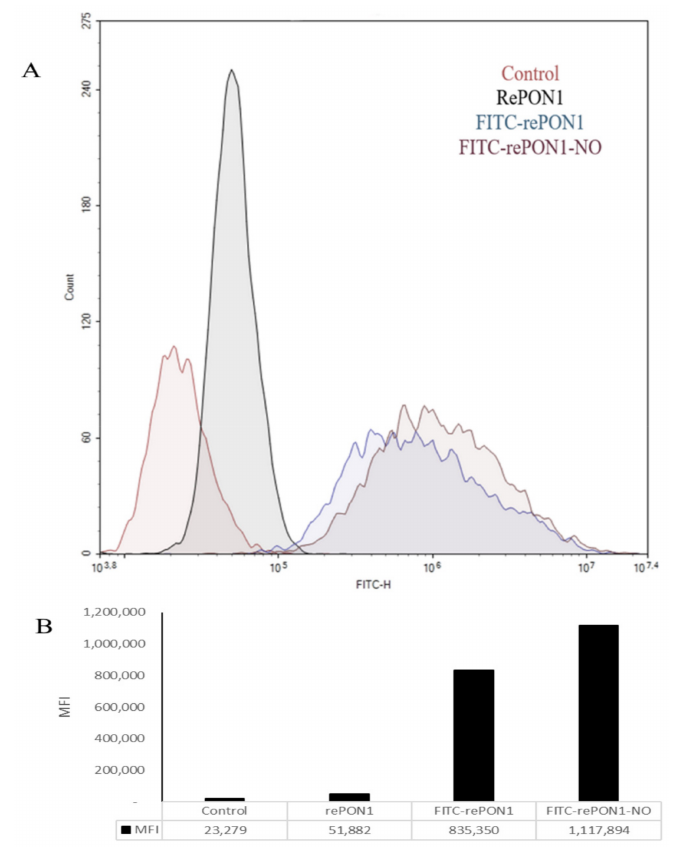
Figure 4. FITC-rePON1-NO influx into macrophage cells compared to FITC-rePON1. RePON1 was labeled with FITC and incubated with GSNO for 3 h to obtain 50% rePON1 S-nitrosylation. Then, rePON1-NO was added to J774A.1 macrophages, incubated at 37 ◦ C for 16 h and analyzed by FACS. ( A ) Histogram shows the shift in mean fluorescence intensity (MFI) in a representative experiment. Control (cells without treatment) in red, rePON1 without FITC as a negative control in black, rePON1 with FITC in blue, and rePON1-NO with FITC in purple. ( B ) MFI of a representative experiment. Results presented using NovoExpress and GraphPad by prism 8.0.1